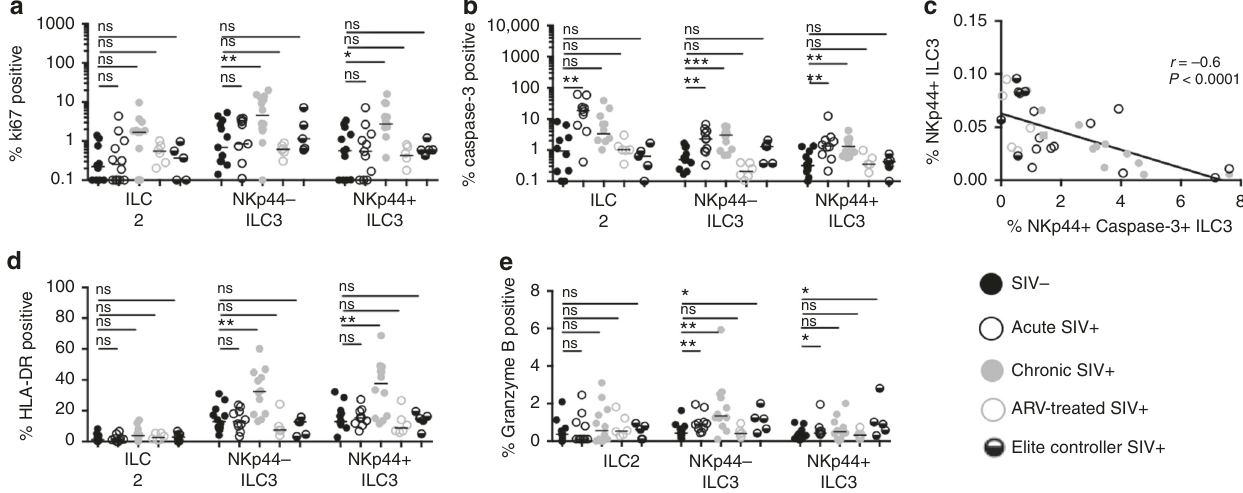
Fig. 3 ILC dysfunction in the SIV + MLN normalizes with ART or elite control. a Frequencies of MLN ILCs in cell cycle in healthy uninfected RMs, untreated acute, and chronic SIV-infected RMs, chronic SIV + RMs receiving ART, and SIV-infected ECs. b Frequencies of MLN ILCs shown to express active caspase- 3 in the uninfected and SIV + MLN. c Relationship between NKp44 + ILC3 frequencies in the MLN and NKp44 + ILC3s expressing active caspase-3. d Percentage of MLN ILCs expressing HLA-DR. e Percentage of MLN ILCs expressing granzyme B. Statistical signi fi cance was calculated using the Mann – Whitney test. A Pearson's correlation was calculated for panel ( c ). ns = P > 0.05, * = P ≤ 0.05, ** = P ≤ 0.01, *** = P ≤ 0.001, and **** = P ≤ 0.0001